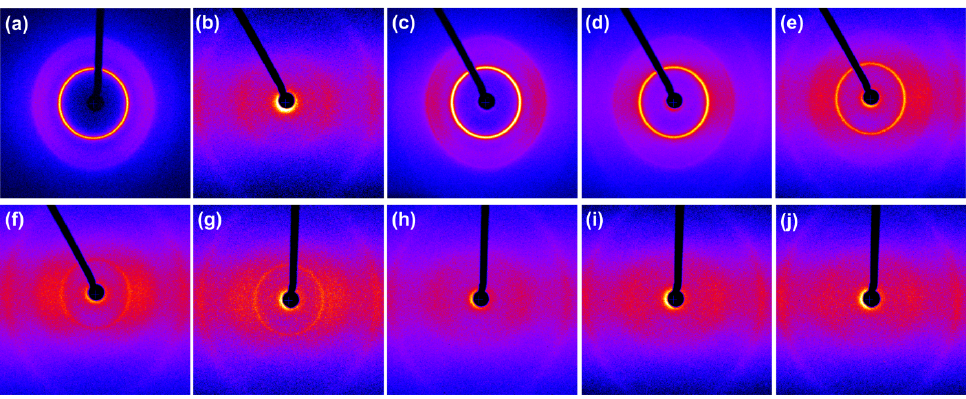
Figure 2. WAXD patterns for the hPBPs at various PT-SWNT/PAN weight concentrations. WAXD patterns for the control PAN film and SWNT BP are also included. ( a ) PAN film, ( b ) SWNT-BP, ( c ) PAN:PT-12.5:1, ( d ) PAN:PT-5:1, ( e ) PAN:PT-2.5:1, ( f ) PAN:PT-1:1, ( g ) PAN:PT-0.67:1, ( h ) PAN:PT- 0.5:1, ( i ) PAN:PT-0.25:1, and ( j ) PAN:PT-0.1:1.